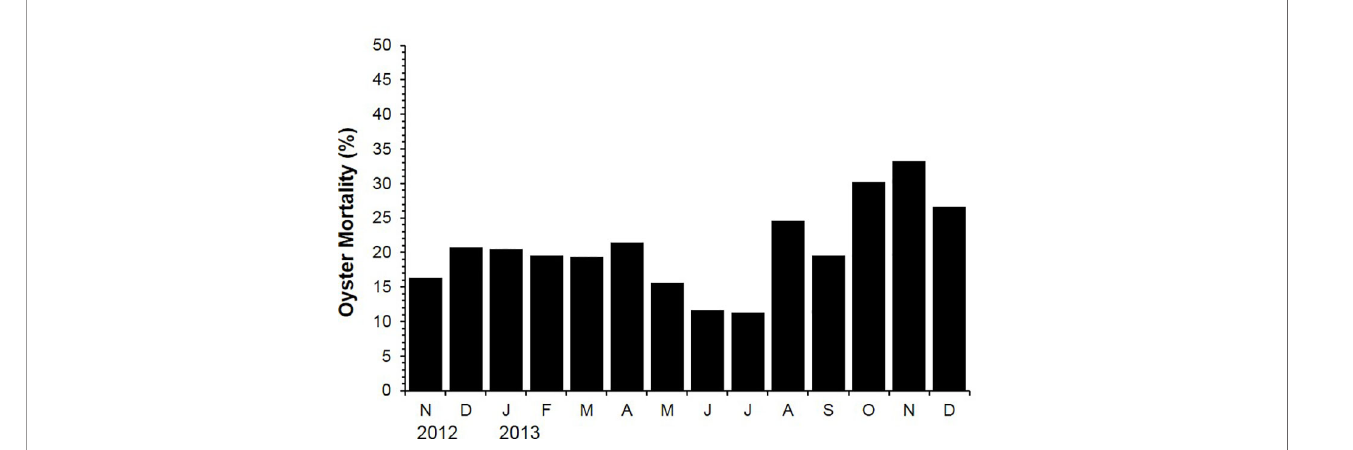
FIGURE 3 | Mortality of the off-bottom rack cultured oysters at the Euhangri beach from July 2012 to